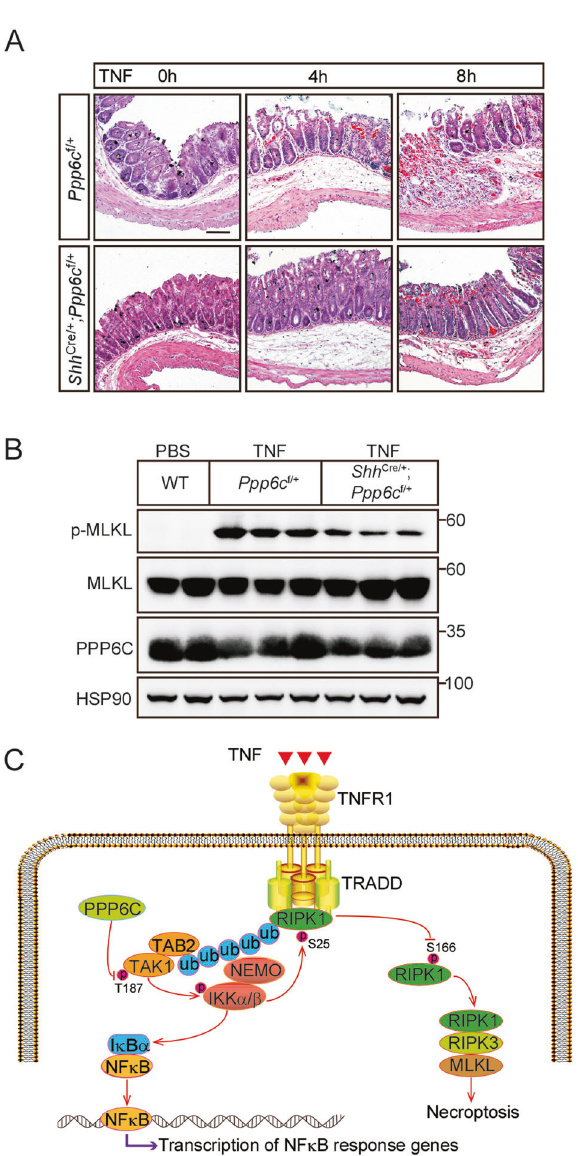
Fig. 5 TAB2 is required for the resistance to TNF-induced necroptotic cell death in PPP6C de fi cient cells. A , B Control and Tab2 -knockdown L929 cells were treated with TZ for the indicated time, and analyzed under a microscope ( A ) or quanti fi ed by fl ow cytometer ( B ) after stained with PI. Scale bar, 50 μ m. C Control and Tab2 -knockdown L929 cells were treated with TZ for the indicated time and then lysed for immunoblot with indicated antibodies. D , E Control and Tab2 -knockdown Ppp6c -KO L929 cells were treated with TZ for the indicated time, and analyzed under a microscope ( D ) or quanti fi ed by fl ow cytometer ( E ) after stained with PI. Scale bar, 50 μ m. F Control and Tab2 -knockdown Ppp6c -KO L929 cells were treated with TZ for the indicated time and then lysed for immunoblot with indicated antibodies. G , H Control and Tab2 - knockdown L929 cells were pretreated with TAK1 inhibitor (5Z-7-Oxozeaenol, 1 μ M) in the presence or absence of Necrostatin-1 (10 μ M) for 30 min, and then treated with TZ for 4 h. Cells were stained with PI and analyzed under a microscope ( G ) or quanti fi ed by fl ow cytometer ( H ). Scale bar, 50 μ m. I Control and Tab2 -knockdown L929 cells were pretreated with TAK1 inhibitor (5Z-7-Oxozeaenol, 1 μ M) for 30 min, and then treated with TNF (10 ng/ml) for the indicated time. Cell lysates were probed with indicated antibodies. Data shown are representative of three